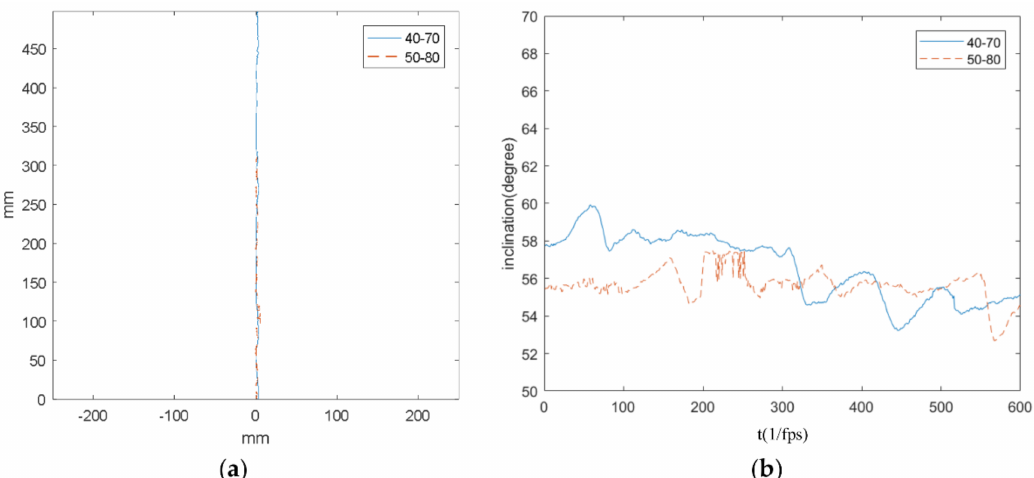
Figure 15. ( a ) The planar COM trajectory of the robot body viewed from above. The solid line indicates that the rolling range is from 40 ◦ to 70 ◦ , and the dashed line indicates the rolling range is from 50 ◦ to 80 ◦ . ( b ) The inclination of the robot body versus time. The solid line indicates that the rolling range is from 40 ◦ to 70 ◦ , and the dashed line indicates that the rolling range is from 50 ◦ to 80 ◦